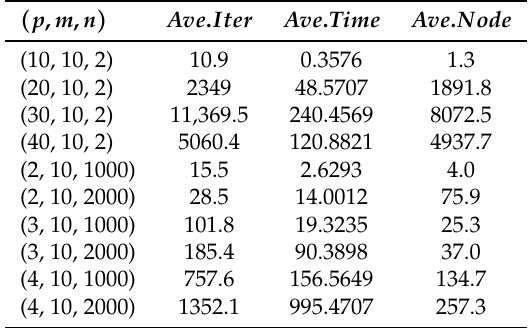
Table 5. The results of random calculation for